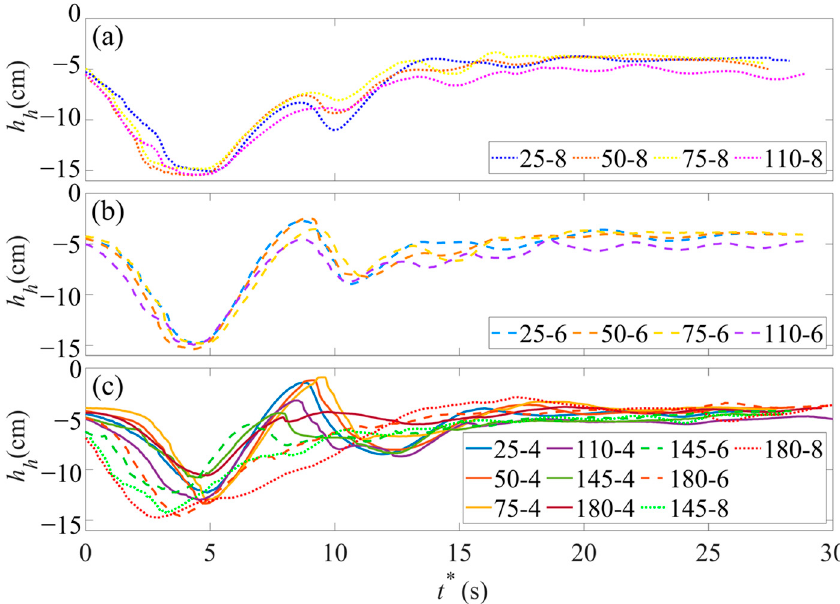
Figure 9. Head position of ISWs when flow climbs along the slope in each case: ( a ) the complete hydraulic jump condition, ( b ) the wavy hydraulic jump condition and ( c ) no hydraulic jump condition.